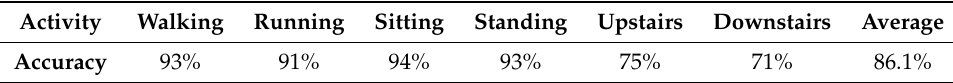
Table 5. Activity recognition accuracy over the internal dataset.